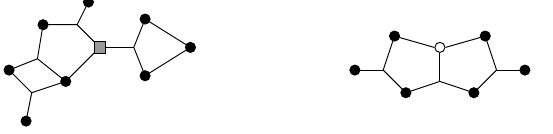
Fig. 2: A hypergraph with an articulation vertex (left) and one without